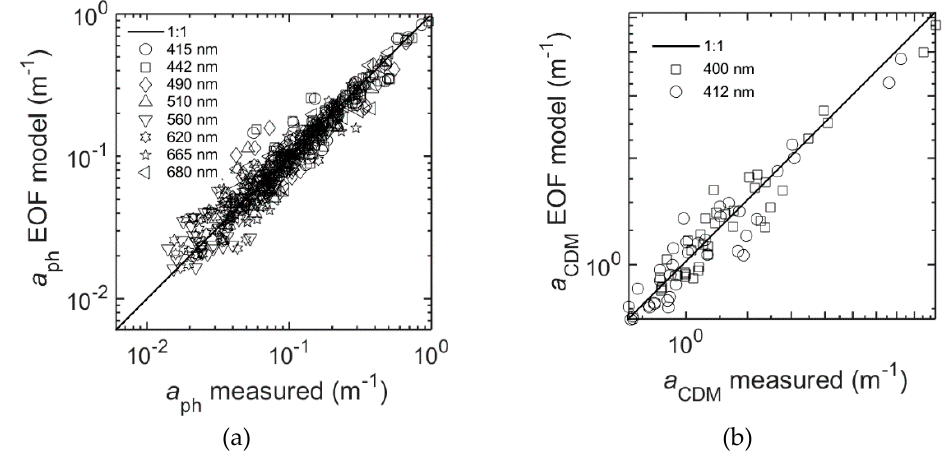
Figure 12. Comparison between phytoplankton ( a ) and CDM ( b ) absorption measured in the laboratory and absorption received from the EOF model for selected wavelengths.